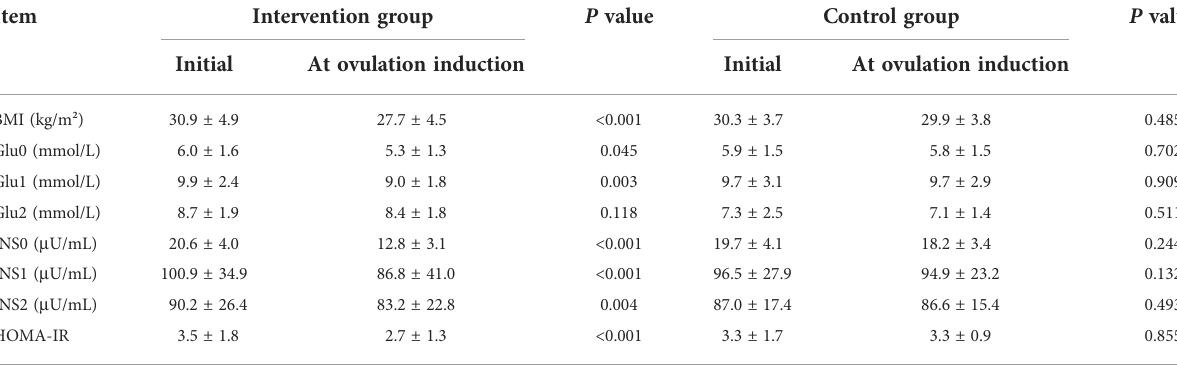
TABLE 2 Comparison of blood glucose and insulin levels between two groups with the change of